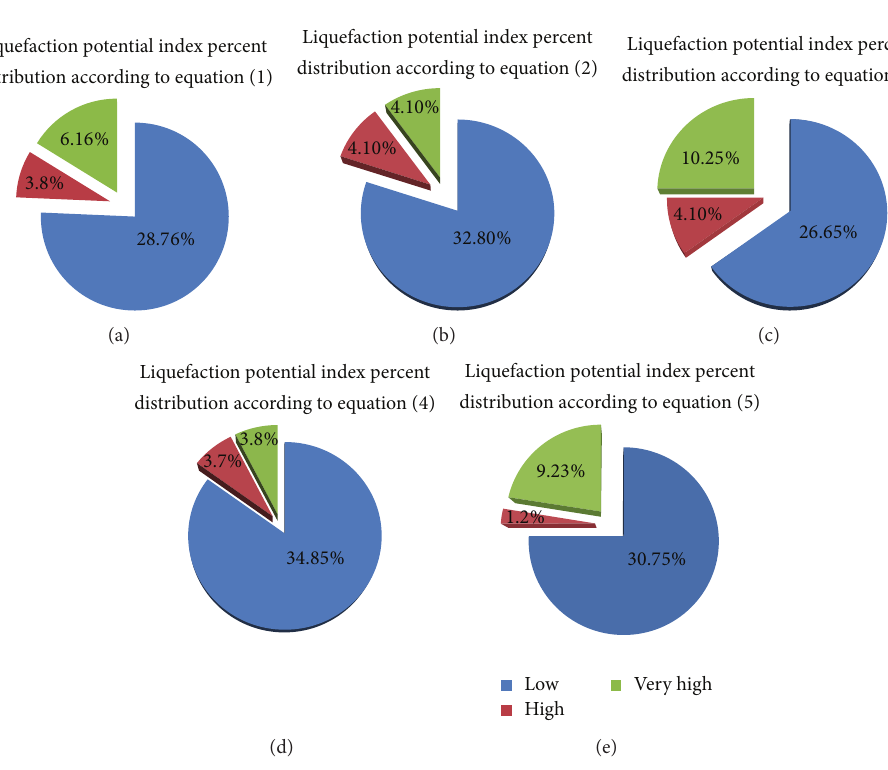
Figure 12: Pie charts showing the areas of the potential